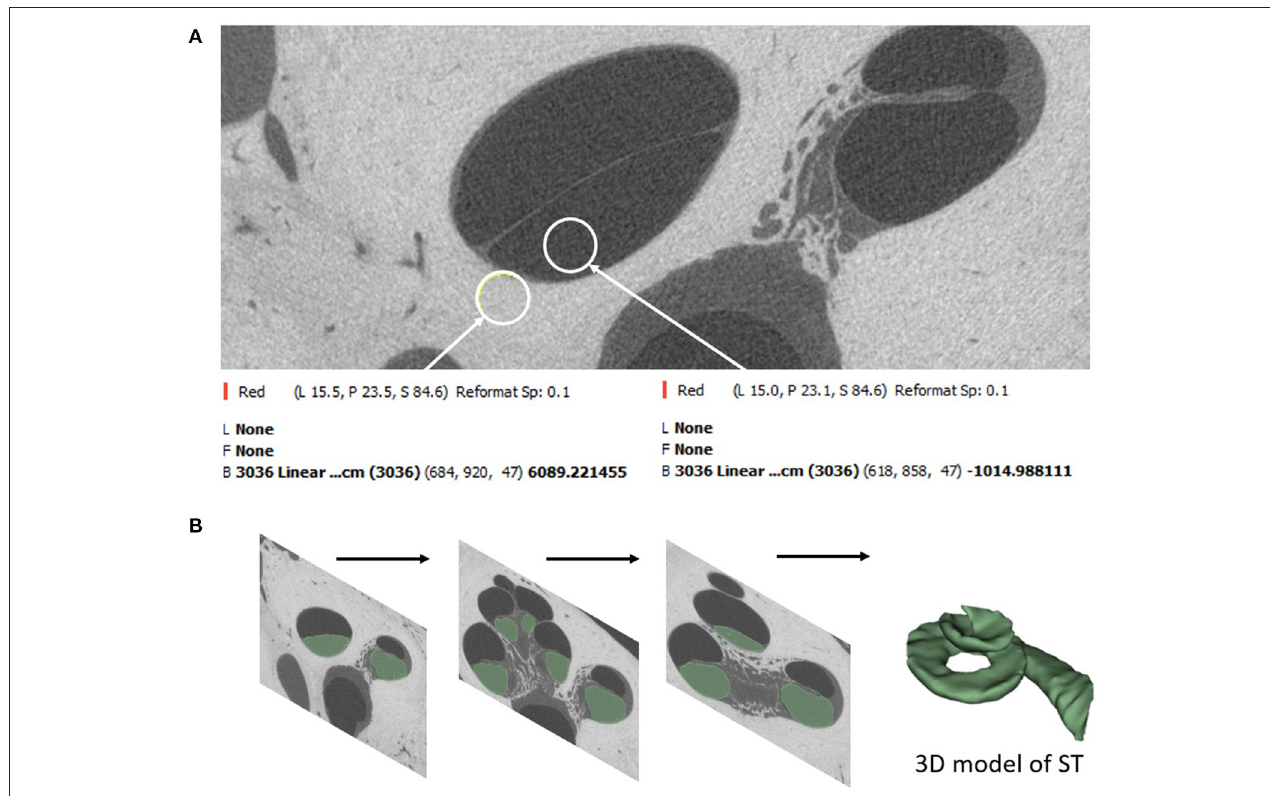
FIGURE 1 | Segmentation of ST starts by setting a tight grayscale threshold that distinguishes between the fluid filled ST and the surrounding bony region (A) . Segmentation is done by shading the areas of interest from all image slices (B) .